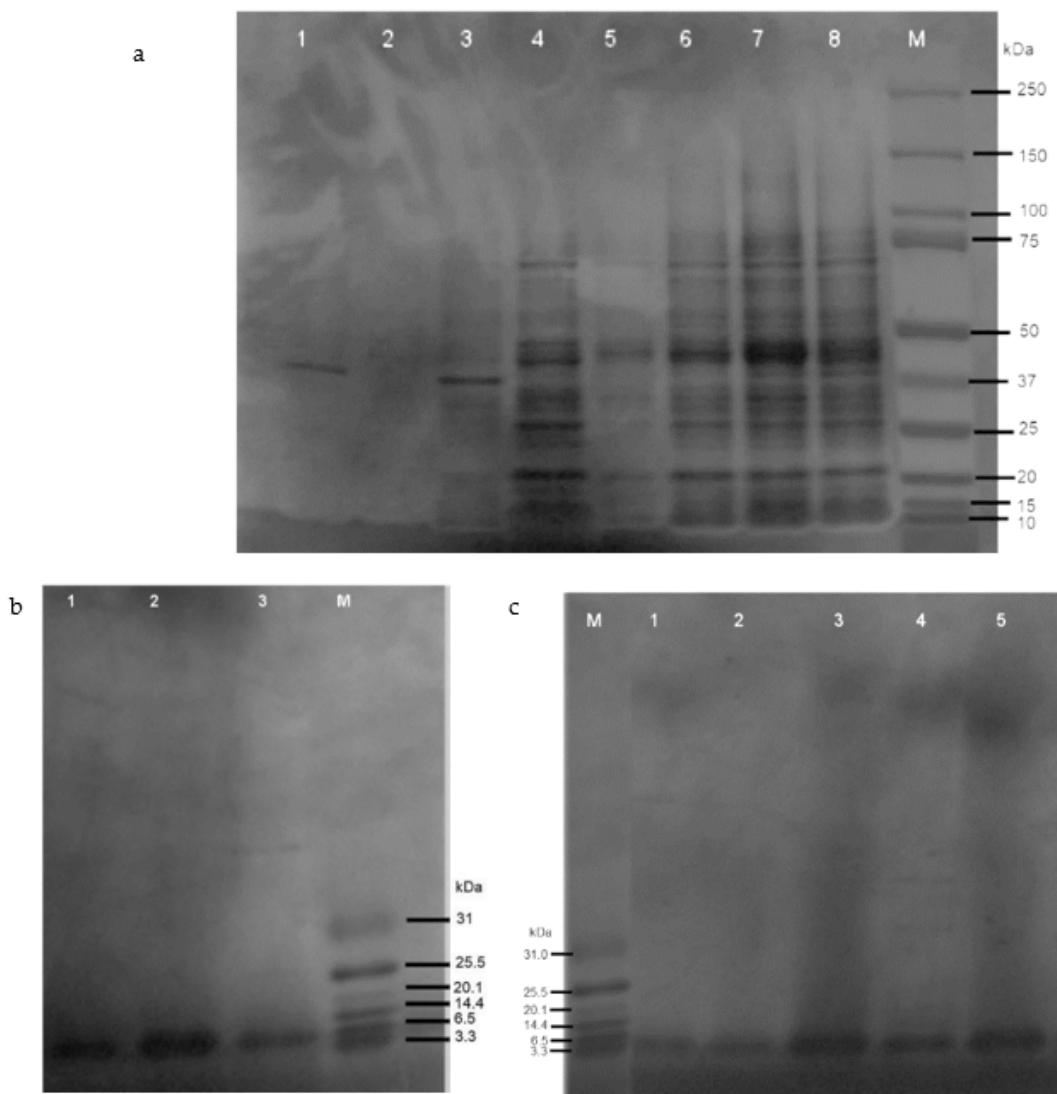
Figure 3. SDS-PAGE analysis of ( a ) recombinant fusion proteins and ( b,c ) purified recombinant pep-